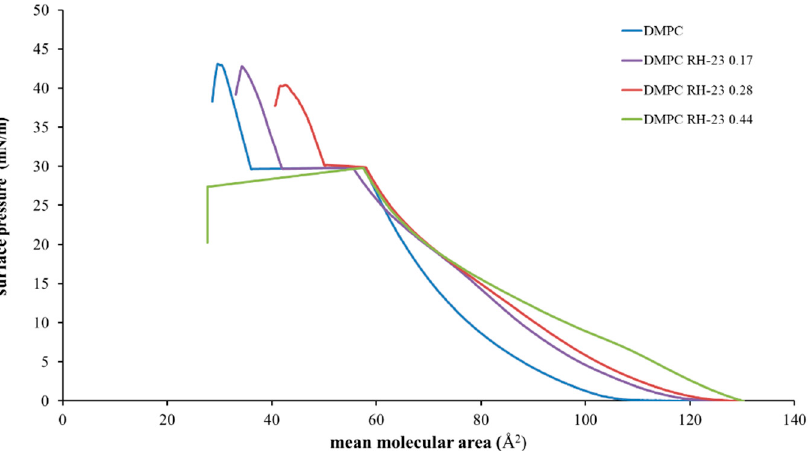
Figure 7. Surface pressure (mN/m)/mean molecular area (Å 2 ) isotherms of DMPC monolayers in the presence of RH-23 at different molar fractions in the subphase with a pause of 30 min at 30 mN/m, at a temperature of 37 ◦ C and pH 7.4.